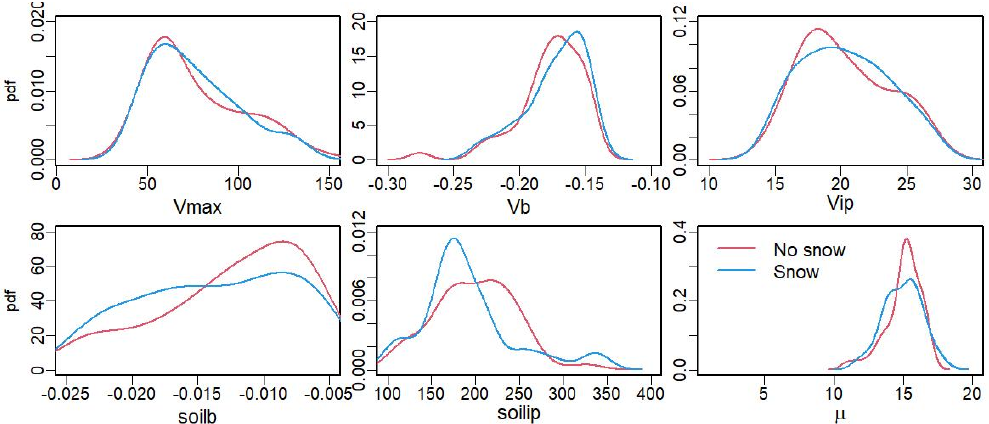
Figure A2. Posterior probability density distributions of the parameters controlling GPP at the EOBS site for the model without (red) and with (blue)